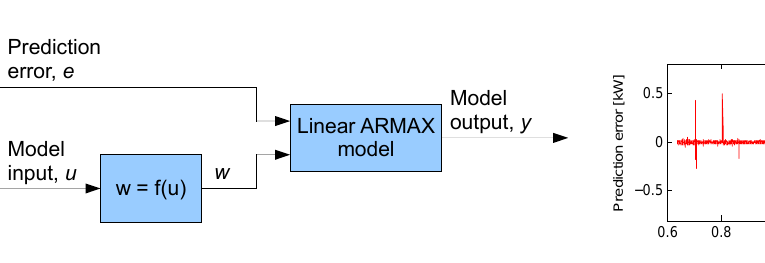
Figure 17: Block diagram of the final Hammerstein model extended with a noise model.